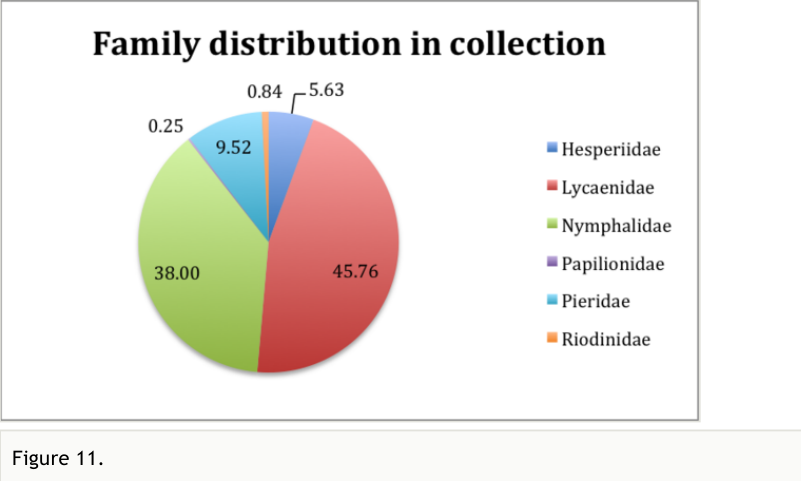
Figure 11. Chart showing the percentage of specimens belonging to the di ff erent families within the British and Irish Lepidoptera collection.